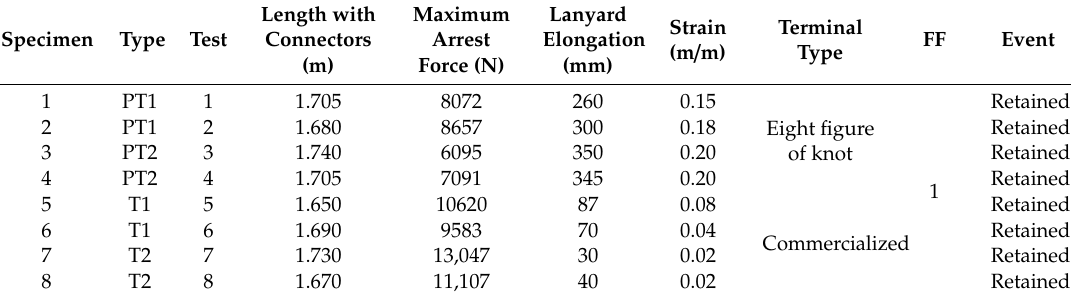
Table 5. Test of specimens. Maximum arrest force and elongation in FF = 1.